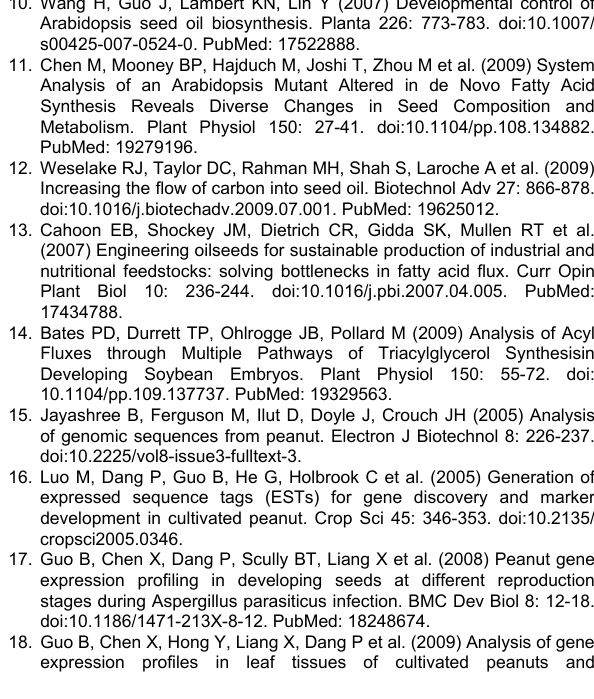
Table S8. Peanut Unigenes in fatty acid metabolism pathway. Table S9. Peanut Unigenes in glycerolipid metabolism pathway. Table S10. Peanut Unigenes in glycerophospholipid metabolism pathway. Table S11. Peanut Unigenes in linoleic and alpha-linolenic acid pathway. Table S12. Fatty acid composition of the total lipid content in mature